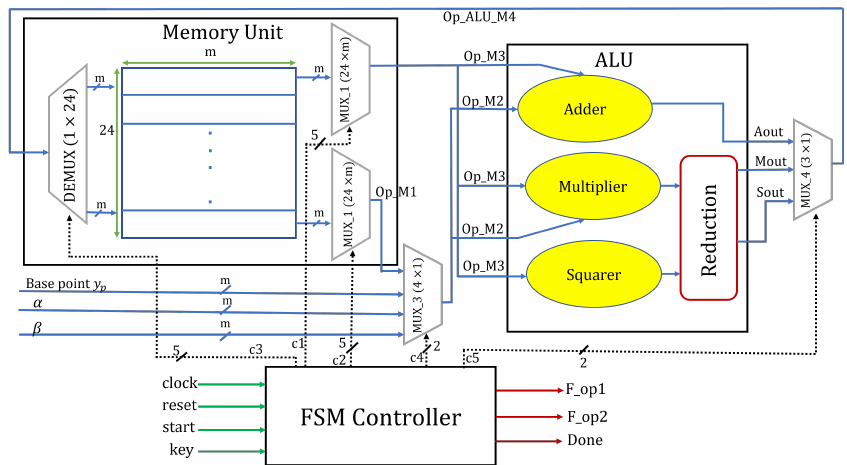
Figure 1. Proposed hardware architecture of BHC for PM